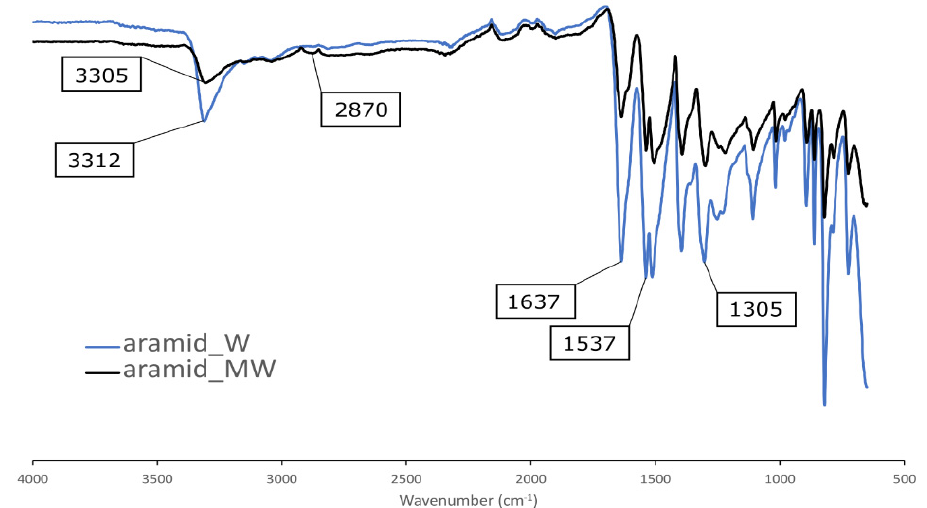
Figure 3. FTIR transmittance spectrum of washed (W) and microwave surface-treated (MW) aramid fibers.